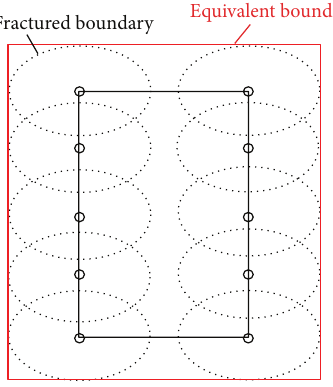
Figure 2: Equivalent boundary of initial cut zone.